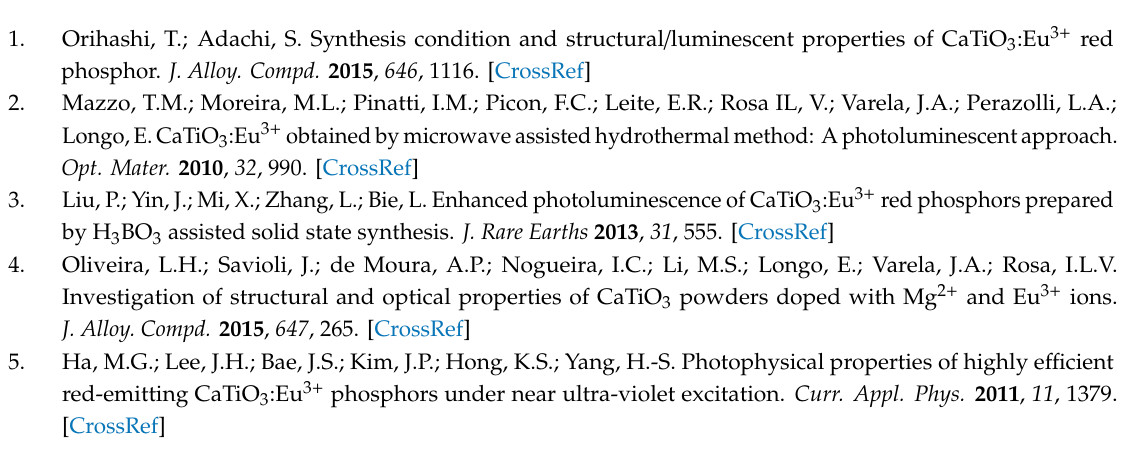
Figure 11. Morphology of Ca 0.97 TiO 3 :Eu 3 + 0.03 phosphors: ( a ) synthesized by the traditional sintering processes; ( b ) synthesized by the microwave-assisted sintering process.